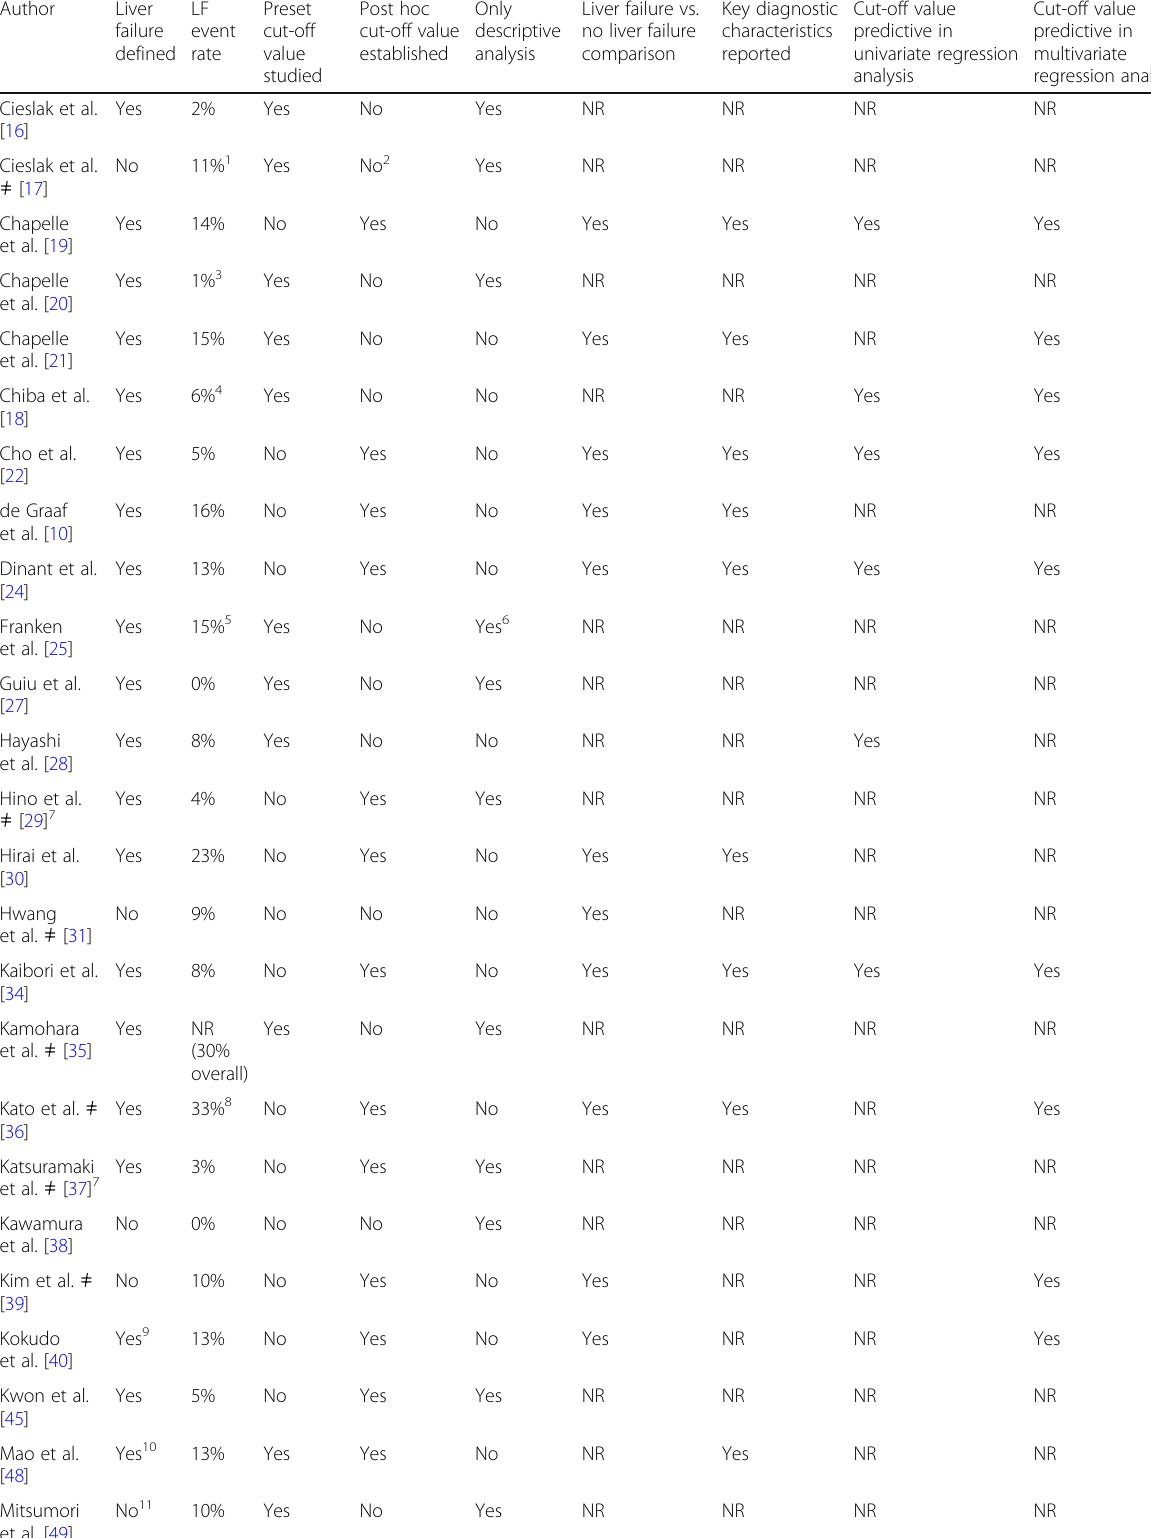
Table 3 Overview of the studies reporting on the correlation between a preoperative nuclear imaging examination and the postoperative outcome liver